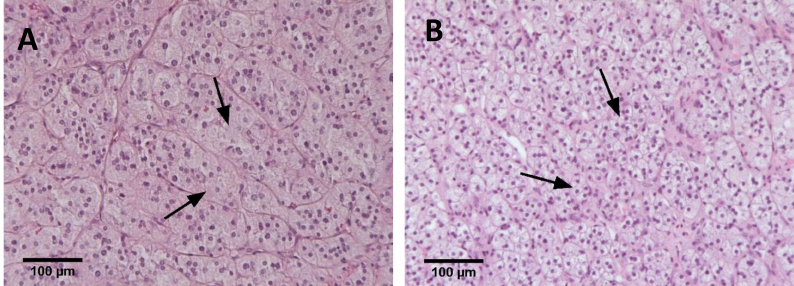
Figure 2. Histopathological phenotype of aldosterone-producing adenomas. Haematoxylin and eosin staining of an aldosterone-producing adenoma showing large lipid-rich cells of the ZF type (indicated with arrows) (panel A ) or a predominance of smaller compact cells of the ZG type (indicated with arrows) (panel B